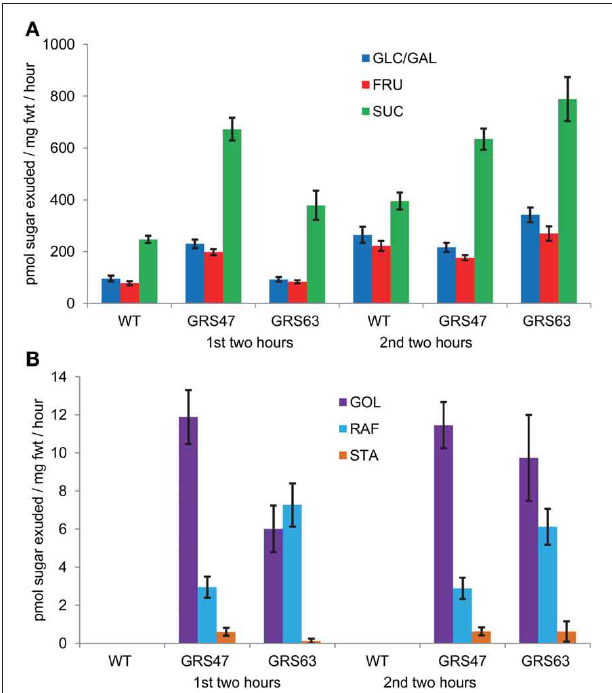
FIGURE 4 | Soluble carbohydrates in phloem exudates from wild type and transgenic plants. (A) Exudation rates for Glc, Fru, and Suc. (B) Exudation rates for Gol, Raf, and Sta. Note the difference scales of the Y axis between (A) and (B) . Variation is expressed as SE; n = 12 sibling